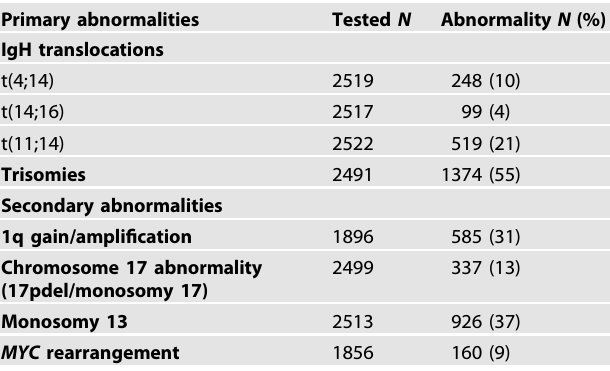
Table 1. Baseline characteristics. Table 2. Cytogenetic abnormalities in multiple myeloma